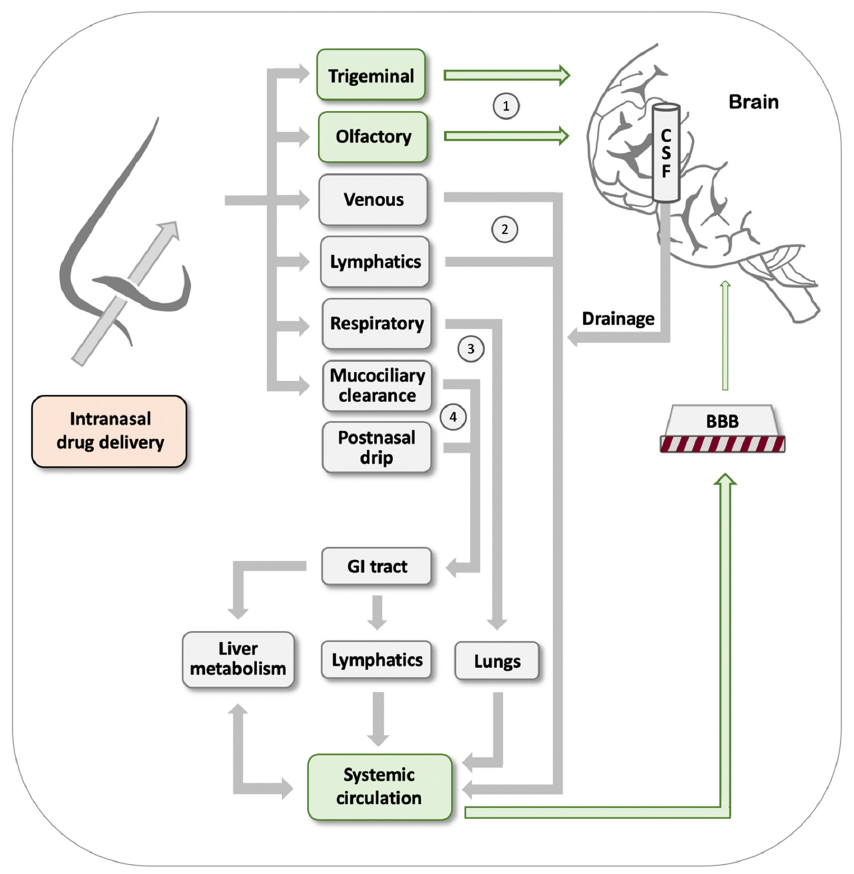
Figure 1. Available routes for intranasal drug delivery. After intranasal delivery, drugs can